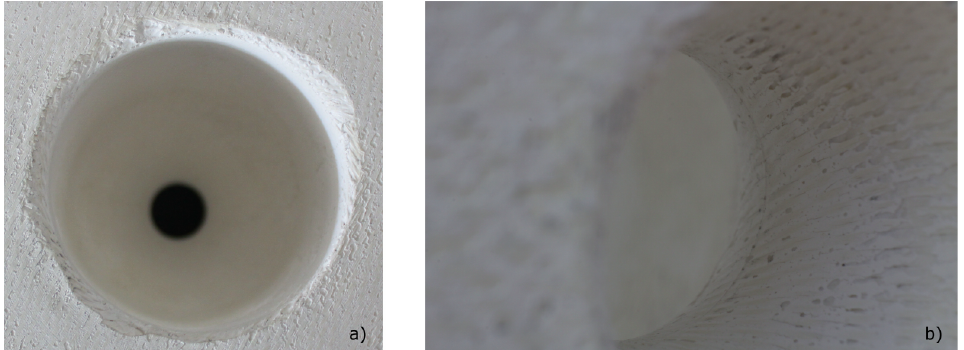
Figure 8. Detailed views of the manufactured prototype: ( a ) the edge at the transition from the cylin- drical combustion chamber to the mounting flange is inhomogeneous and not sharp, ( b ) the nozzle neck shows a relatively smooth surface with a nevertheless visible fibre structure.